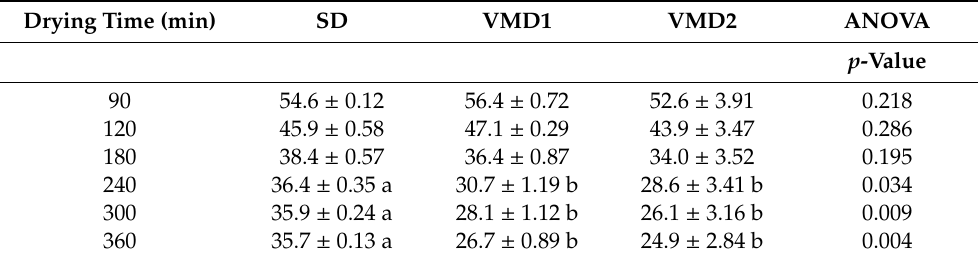
Table 3. Multiple sample comparison of drying profiles (SD, VMD1, and VMD2) at different time intervals.